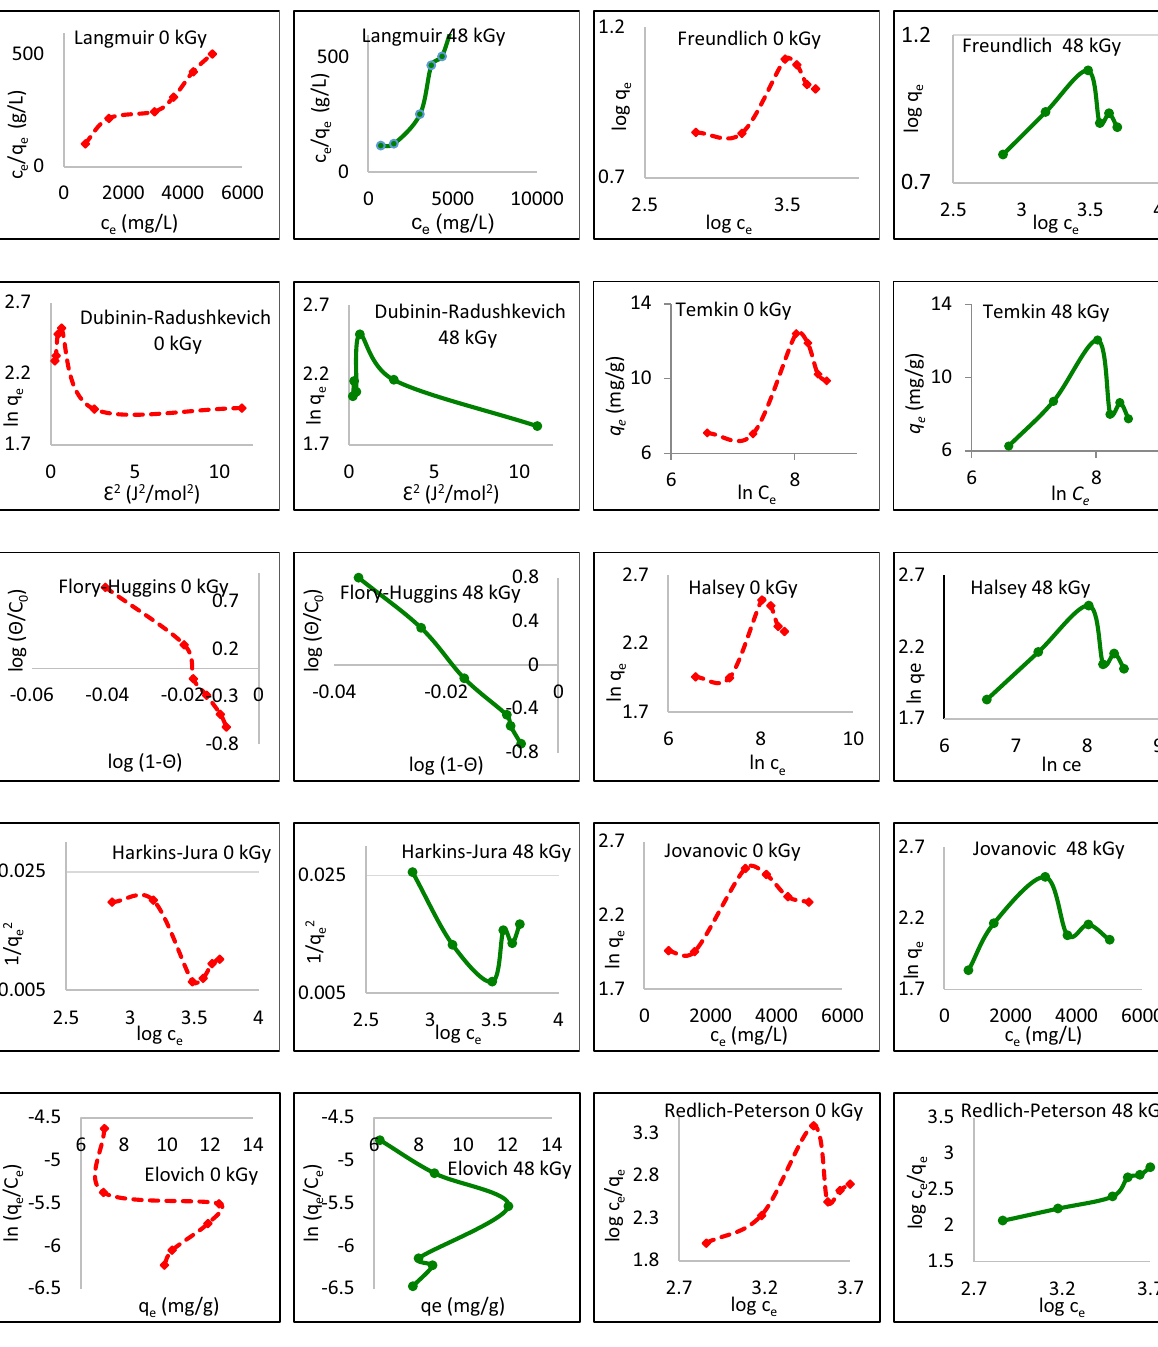
Figure 3: Selection of all tested adsorption models for Cu ( II ) sorption on the sheep wool dosed 0 and 48